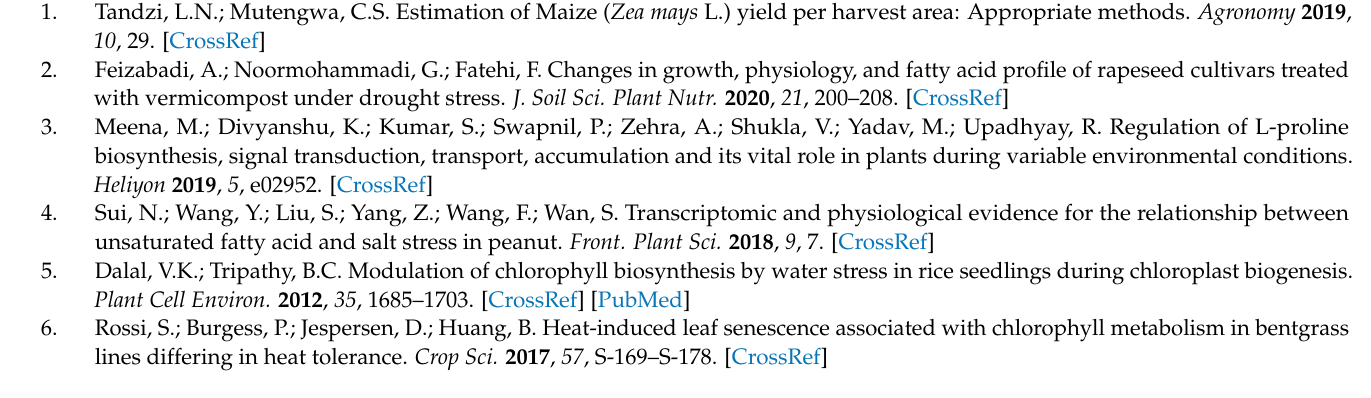
ments, Figure S2: OPLS-DA validation models, Figure S3: Secondary metabolism pathways, Figure S4: Glucosinolates biosynthesis pathway, Table S1: Dataset, Table S2: Statistically significant metabolites of lettuces grown under 0 mM NaCl, Table S3: Statistically significant metabolites of lettuces grown under 40 mM NaCl, Table S4: VIP